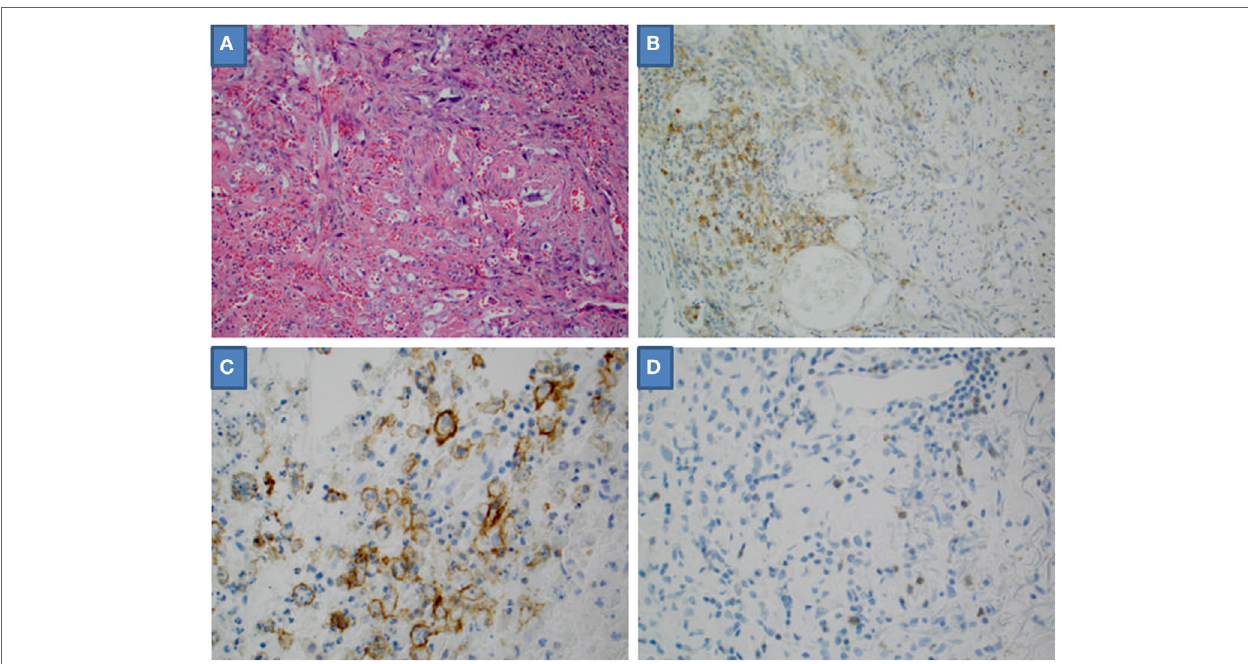
FigUre 1 | Microscopic high-powered view of angiosarcoma. (a) Hematoxylin and eosin stain. (B) Tumor-infiltrating immune cells positive for programmed death-ligand 1 (PD-L1). (c) Tumor cells positive for PD-L1. (D) Tumor-infiltrating immune cells positive for programmed death